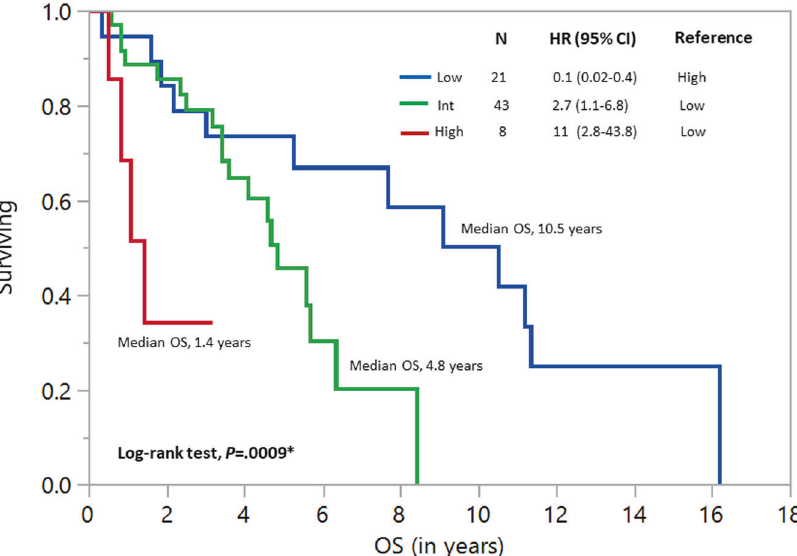
Fig. 2 Figure showing operational survival model using hemoglobin ≤ 10 gm/dL and abnormal karyotype (excluding -Y) identi fi ed as independent signi fi cant variables using multivariate analysis. Patients were diving into three survival categories; low [median OS 10.5 years 95% CI (3 – 11.3)], intermediate [median OS 4.8 years 95% CI (3.4 – 6.3) and high-risk [median OS 1.4 years, 95% CI (0.5-not reached), P = 0.0009] categories. Statistical signi fi cance ( P < 0.05) is denoted by *, calculated through the log-rank cytogenetic abnormalities such as t(3;3)(q21.2;q26.2), inv(3) (q21.23q26.2) or isolated del(5q). Further, ASXL1 and SETBP1 model [13]. When we reclassi fi ed our patients as per the contemporary WHO de fi nition of MDS/MPN-RS-T, only Hb ≤ 10 gm/dL and abnormal karyotype (without -Y) retained indepen- dent prognostic signi fi cance. Although the presence of any ASXL1 mutation was unable to predict an adverse OS in a univariate analysis; frameshift and nonsense ASXL1 mutations were able to do so, similar to previously published studies [13, 16]. Another study identi fi ed SF3B1 and JAK2V617F as independent predictors of favorable prognosis, however these could not be validated in our cohort [17]. These data highlight that the contemporary WHO- de fi ned MDS/MPN-RS-T category is clinically and molecularly less heterogenous than RARS-T, and yet this classi fi cation has key limitations. An operational survival model relying on hemoglobin ≤ 10 g/dL (1 point) and abnormal karyotype (1 point) was able to risk stratify MDS/MPN-RS-T patients into low (0 points), intermediate (1 point), and high-risk categories (2 points), respectively. High-risk MDS/MPN-RS-T patients have an inferior median OS (1.4 years)